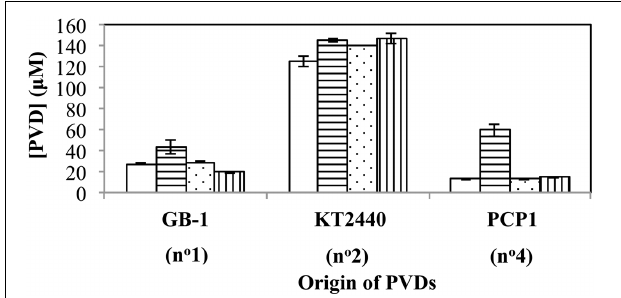
FIGURE 7 | Concentration of PVD observed 2 days after the addition of varying amounts of PVDGB-1 to P. putida GB-1 cultures. [Fe(II)] = 2 μ M (added as FeSO 4 • 7H 2 O). The concentration of the added PVD was varied from 0 to 10 μ M. Error bars indicate the standard deviation of measurement of triplicate samples. Fe(II) was added to fully repress PVD synthesis at the condition without added PVD. For all samples containing PVD, however, the initial Fe(II)-PVD complex was expected to be rapidly air oxidized to Fe(III)-PVD (Xiao and Kisaalita, 1998), consistent with data in Figure 5 .